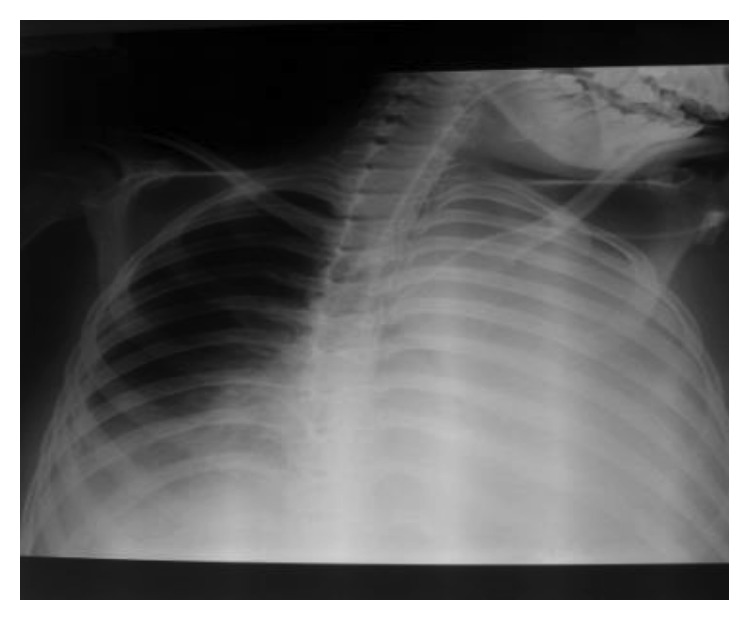
Pleural effusion.